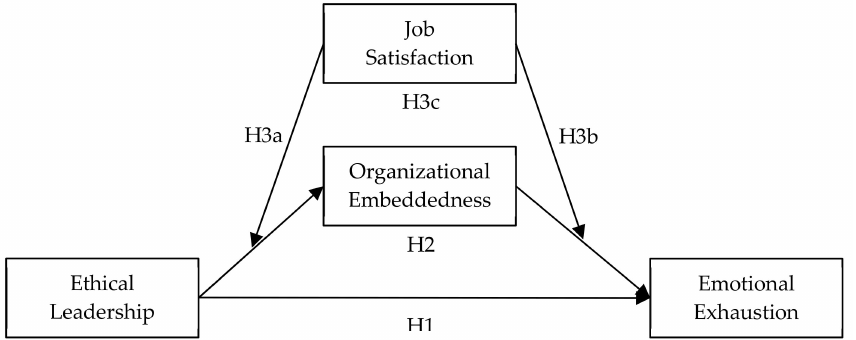
Figure 1. Theoretical